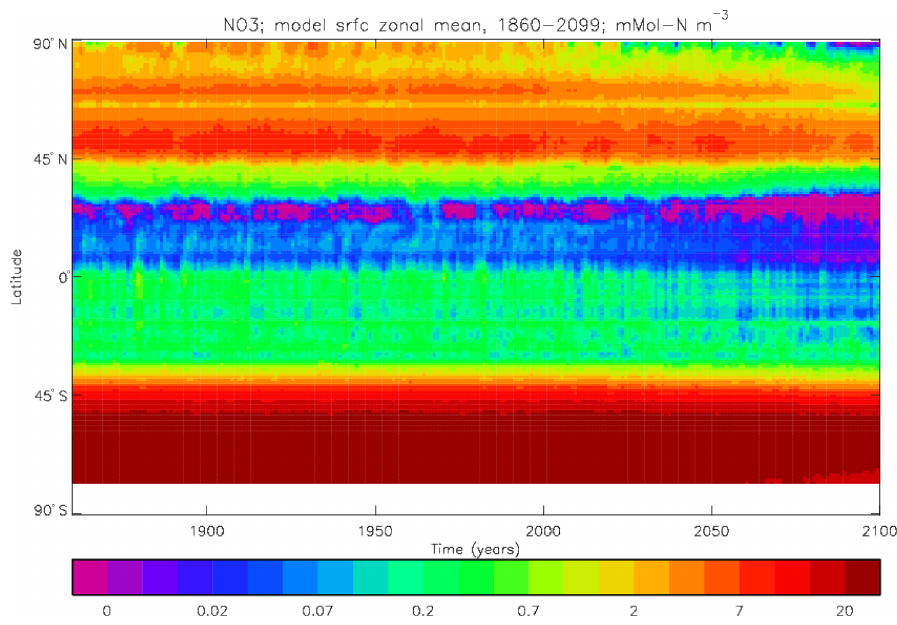
Figure 34. Surface dissolved nitrate concentration (mMolNm − 3 ): global zonal and annual means for model years 1860 to 2099 from the CMIP5 historical and RCP8.5 simulations, showing the response to changing climatic